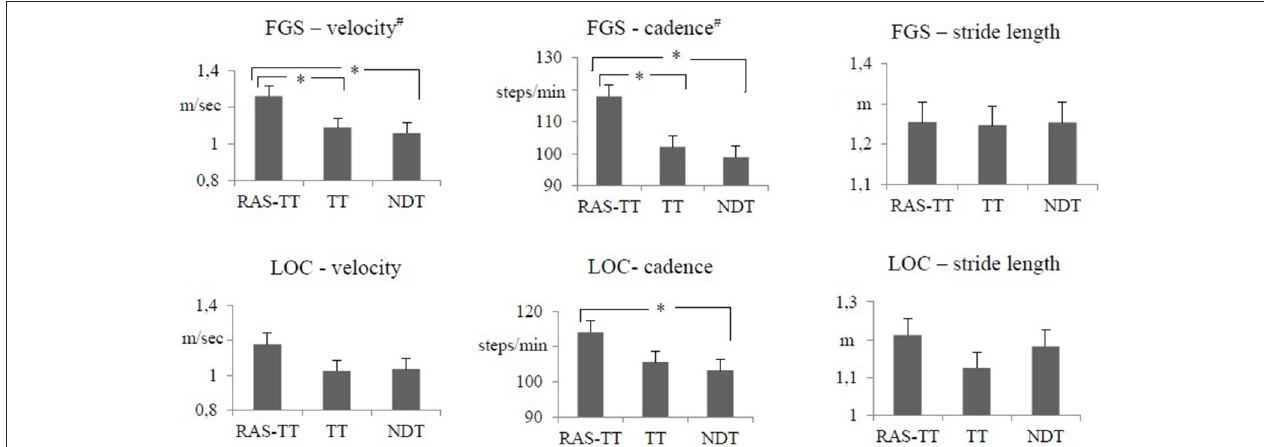
FIGURE 2 | Primary outcome measures: adjusted means of post intervention gait parameters with pre-intervention measures and time between stroke and study entrance as co-varieties. Error bars indicate the standard error. # Statistically significant group difference. *Statistically significant group contrast. ( p < 0.05). RAS-TT, rhythmic auditory stimulation with treadmill training; TT, treadmill training; NDT, neurodevelopmental treatment; FGS, fast gait speed test; LOC, gait analysis with